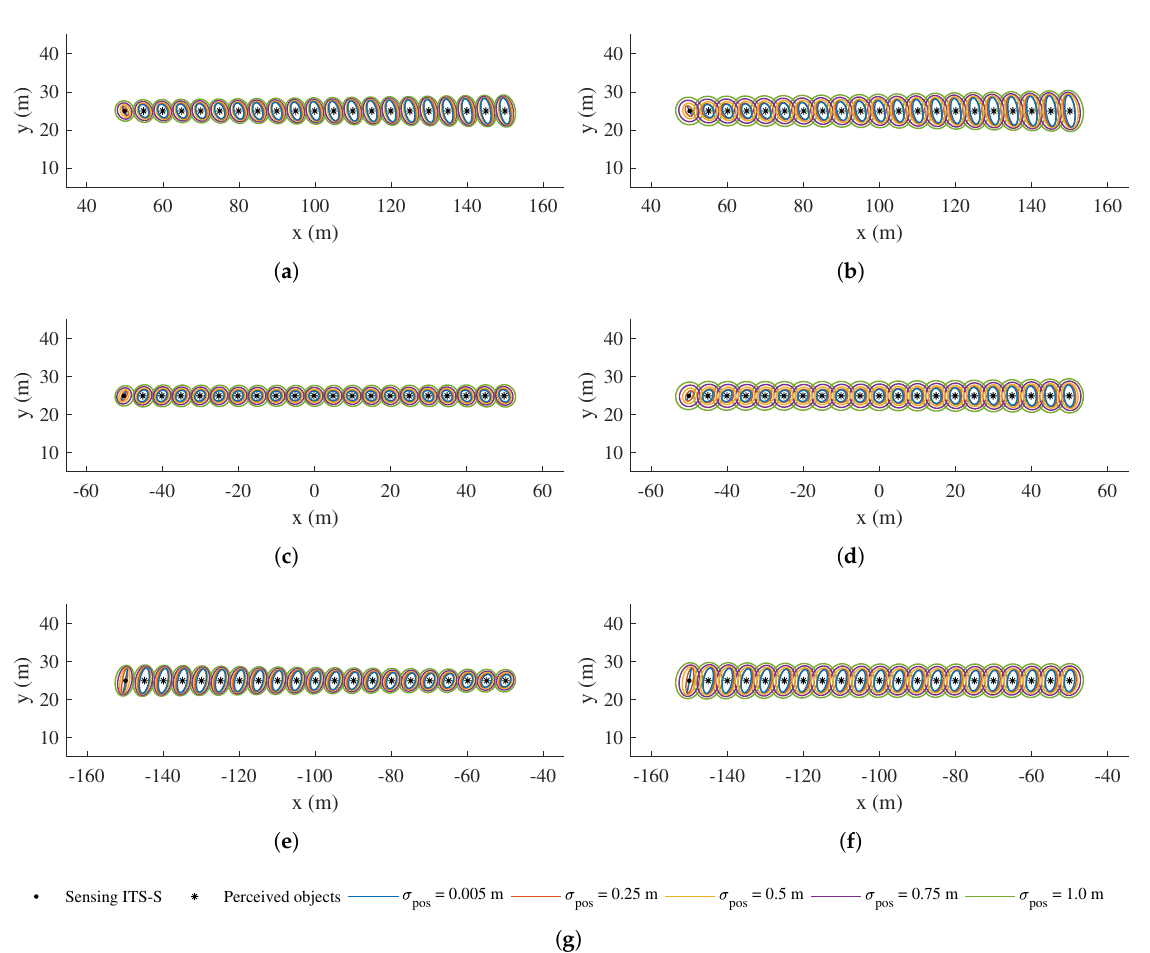
Figure 12. Confidence ellipses of perceived objects transformed to the local frame of the receiving CAV in Test 2 , with different standard deviations in position estimate of CAV(s). ( a , c , e ) demonstrate the results for the V2I case, while ( b , d , f ) illustrate the results for the V2V case at different relative positions. In each subfigure, the first object on the left represents the position of the sensing ITS (visualised as a black dot) after being transformed to the receiving CAV’s local frame, while its perceived objects are denoted by black star markers. The receiving CAV sits at the origin in each subfigure. Each ellipse represents 95% of position estimate